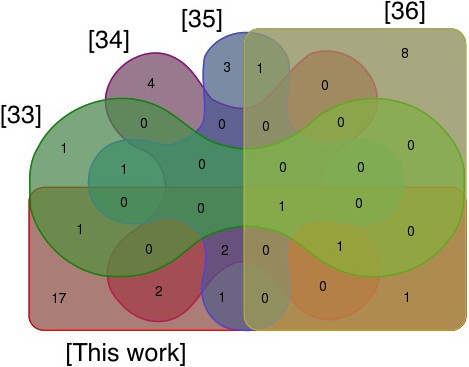
Venn diagrams - Groups of proteins per article and mutual proteins between them. (Sritippayawan et al.,
[33]); (Tyan et al.,
[34]); (Wang et al.,
[35]); (Wang et al.,
[36]); and the proteins identified in this work.